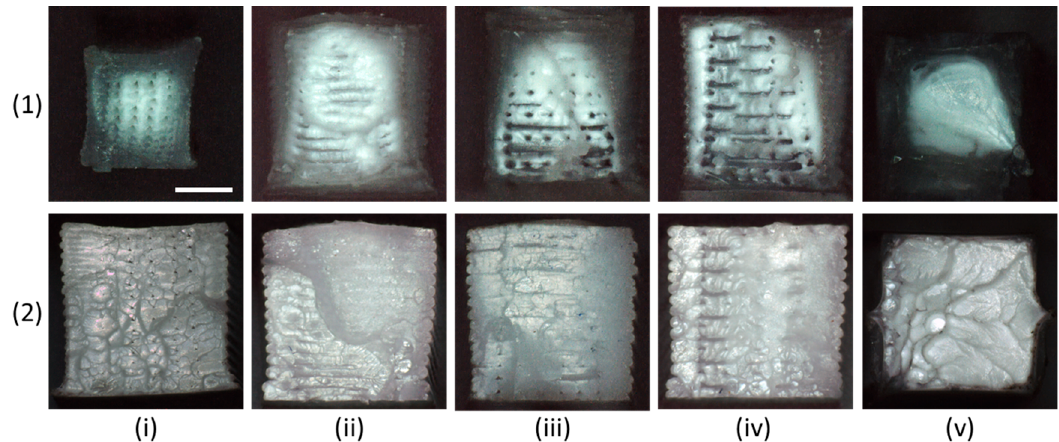
Figure 13. Digital microscope images of cross sections of the broken test pieces. ( i ) P., ( ii ) V., ( iii ) P.V., ( iv ) C., and ( v ) I.M. ( 1 ) non-immersion test pieces, ( 2 ) immersed in saline for 30 days. Bar: 1 mm.